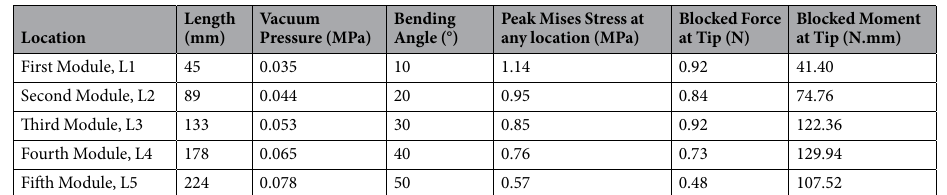
Table 3. Design parameters for theV-SPA robotic assembly to enable spinal column